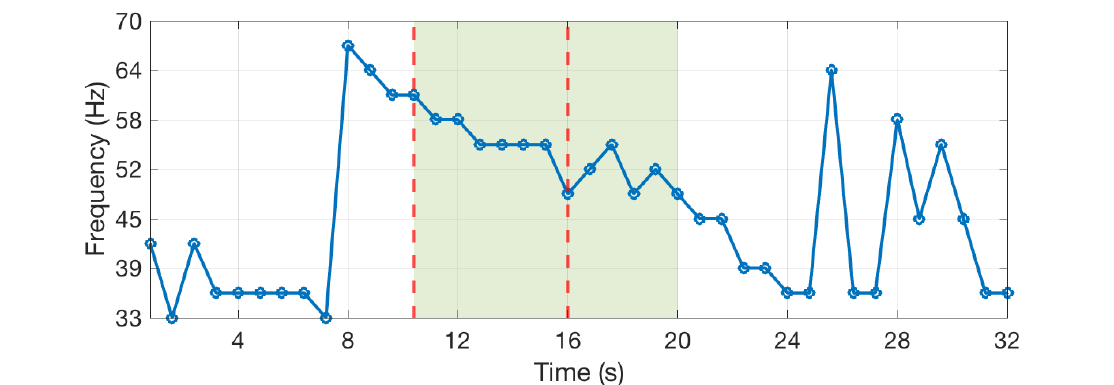
Figure 12. Frequencies corresponding to the maximum amplitudes of the